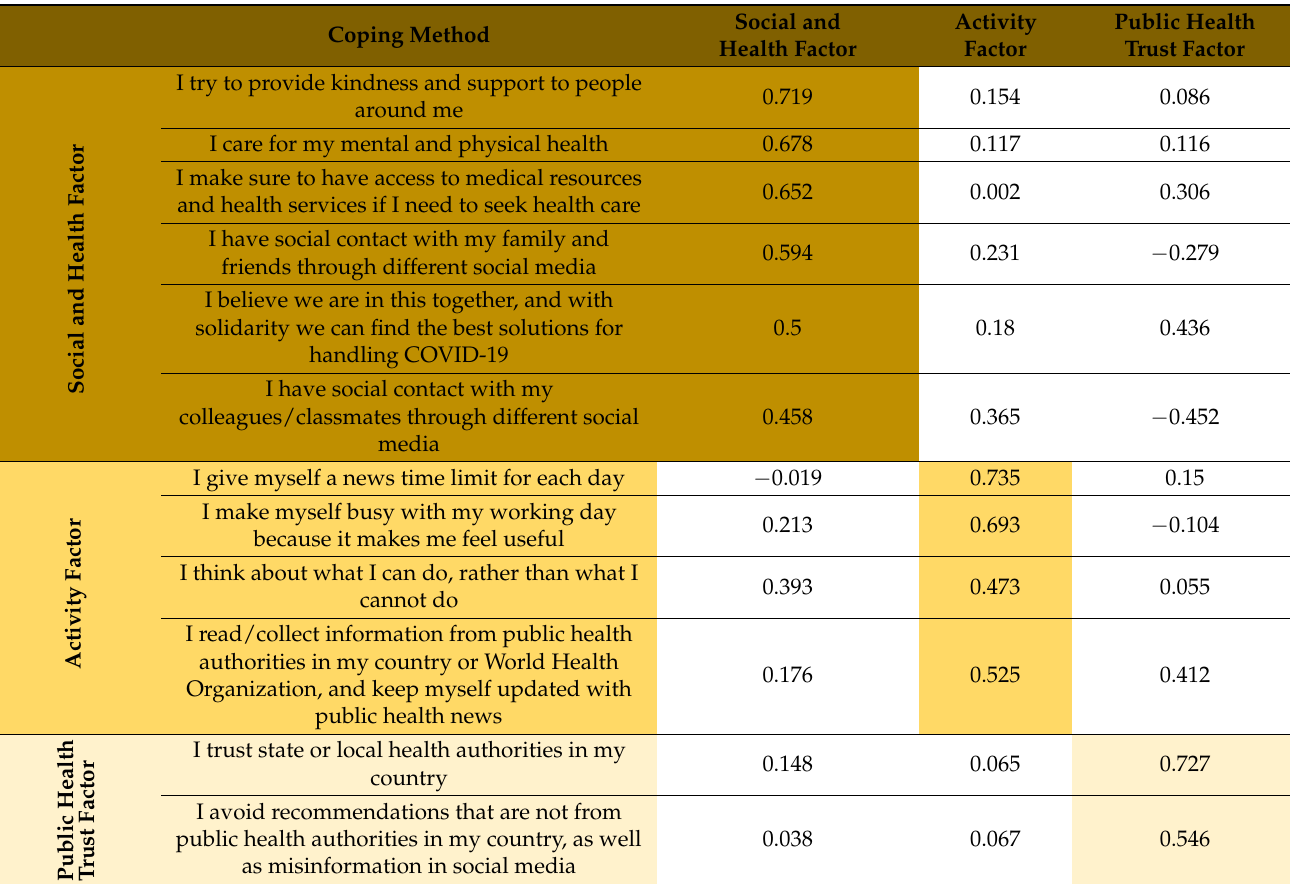
Table 2. Factor analysis of methods of coping with challenges of working from home. Coping Method